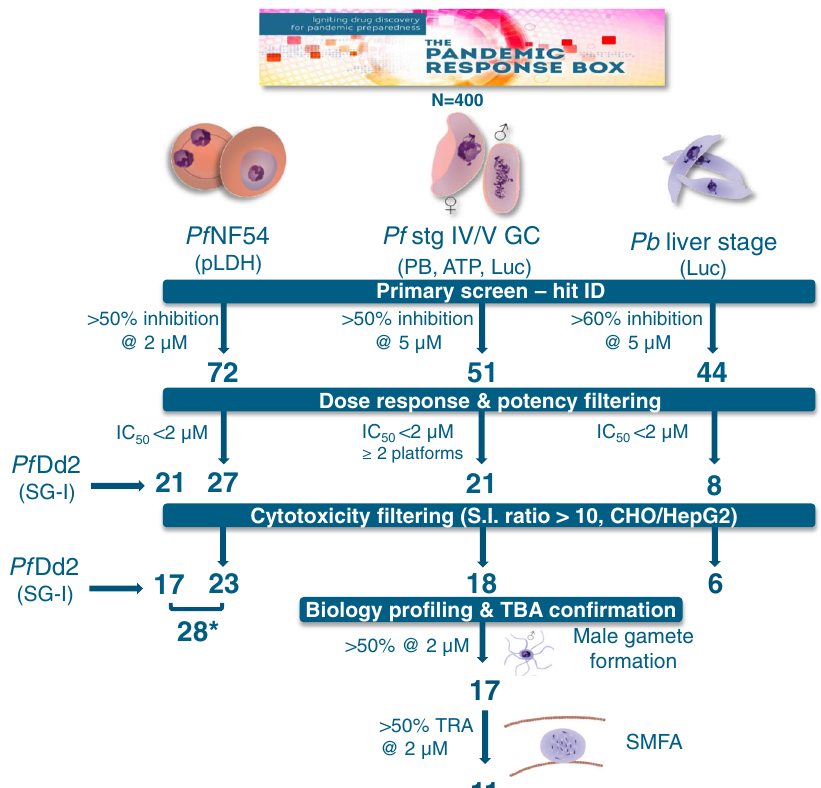
Fig. 1 Screening cascade of the MMV Pandemic Response Box for activity against multiple life cycle stages of Plasmodium . The 400 compounds in the PRB were screened in a primary assay against drug-sensitive (NF54) P. falciparum asexual blood stages (ABS, at 2 and 20 µ M) and mature gametocytes (stage IV/V, GC, 1 and 5 µ M) and P. berghei liver stages (5 µ M). Hits were selected based on ≥ 50% inhibition at speci fi c concentrations as indicated. The criteria for each decision point are indicated followed by the number of compounds that passed the criteria. Compounds were additionally evaluated in dose response on drug-resistant asexual Dd2 parasites (chloroquine, pyrimethamine and me fl oquine resistant). * = the potent ABS compounds (IC 50 < 2 µ M), after removing toxic compounds and eliminating overlapping compounds between Pf NF54 and Pf Dd2, amount to 28 compounds in total. IC